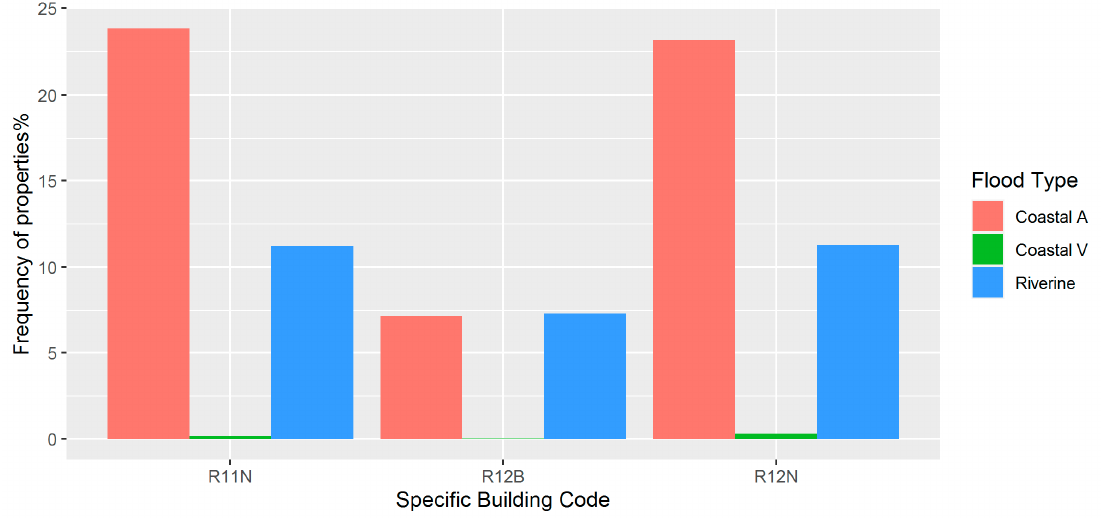
Figure 4. The percentage of properties in the most frequent SpCode groups across different flood schemes.